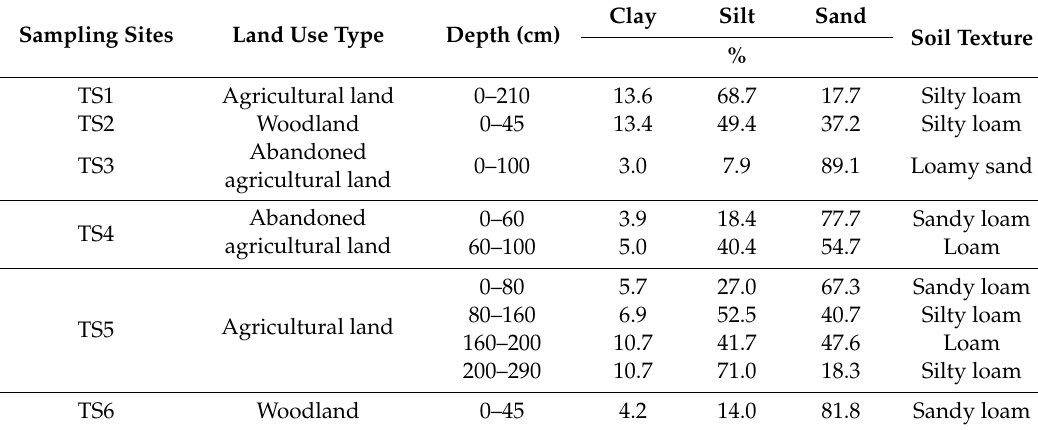
Table 5. The soil texture in each profile.